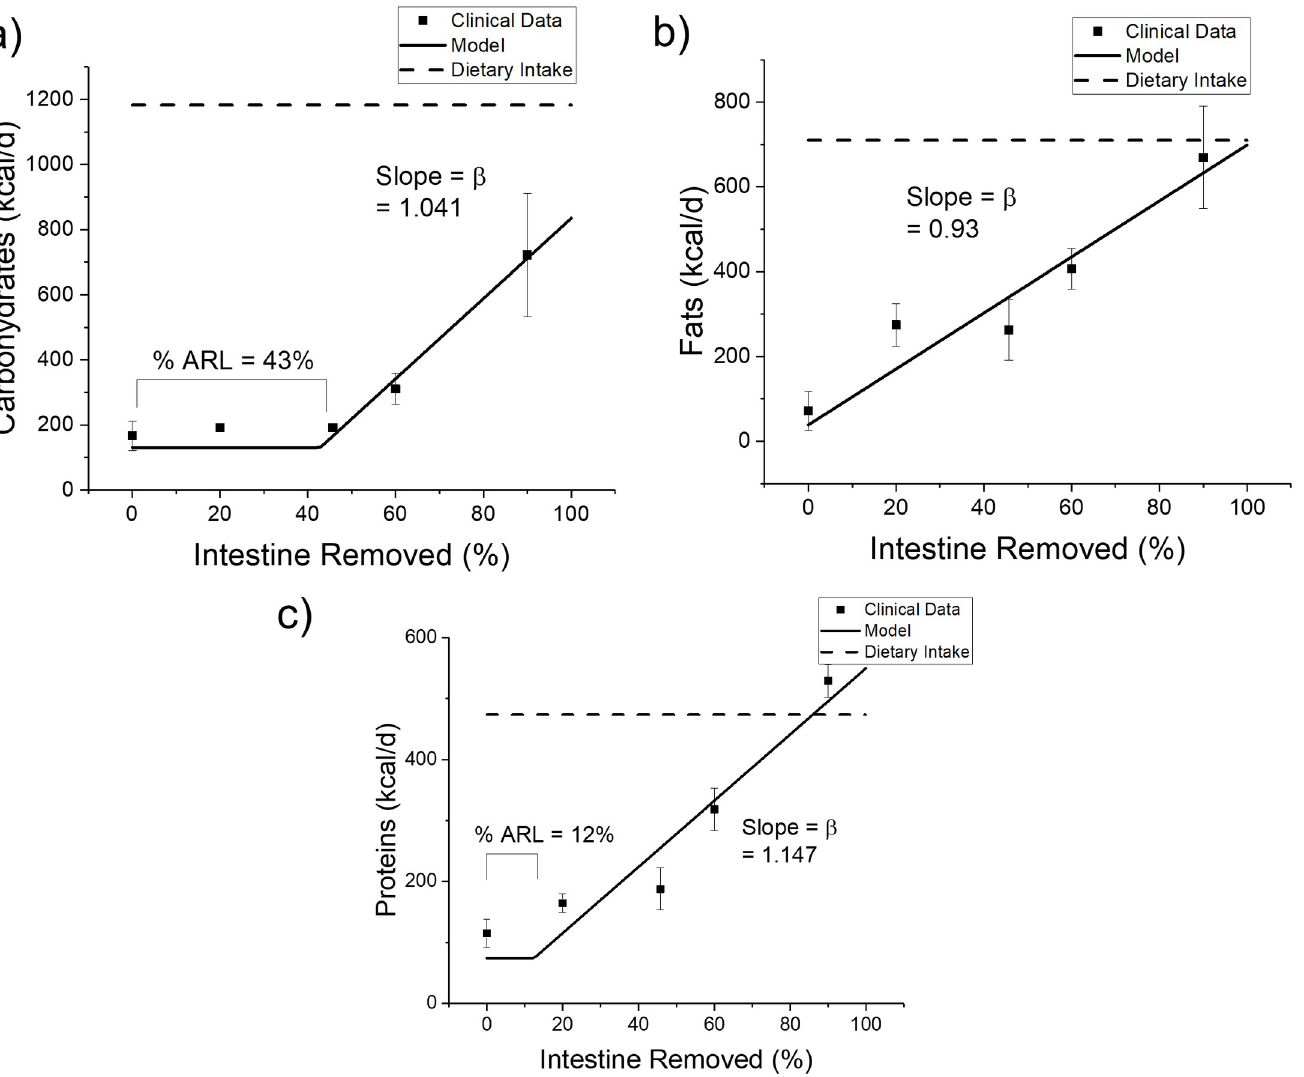
Fig 2. The effect of varying degrees of small-intestine resection on Ileocecal output (ICO) of carbohydrates, fats, and proteins. Model estimates using Eq 10 (solid lines) agree well with a dataset (points) from Nordgaard et al. [15]. Each data point represents an average of the measurements on multiple subjects (n = 2 to 15) with the error bar describing the standard error. Dietary intake is shown as dotted lines. % ARL stands for the percentage of anatomical reserve length as defined in Eq 10. The coefficient of determination for carbohydrate R 2 = 0.9698, fat R 2 = 0.8954, and protein R 2 = 0.9085.